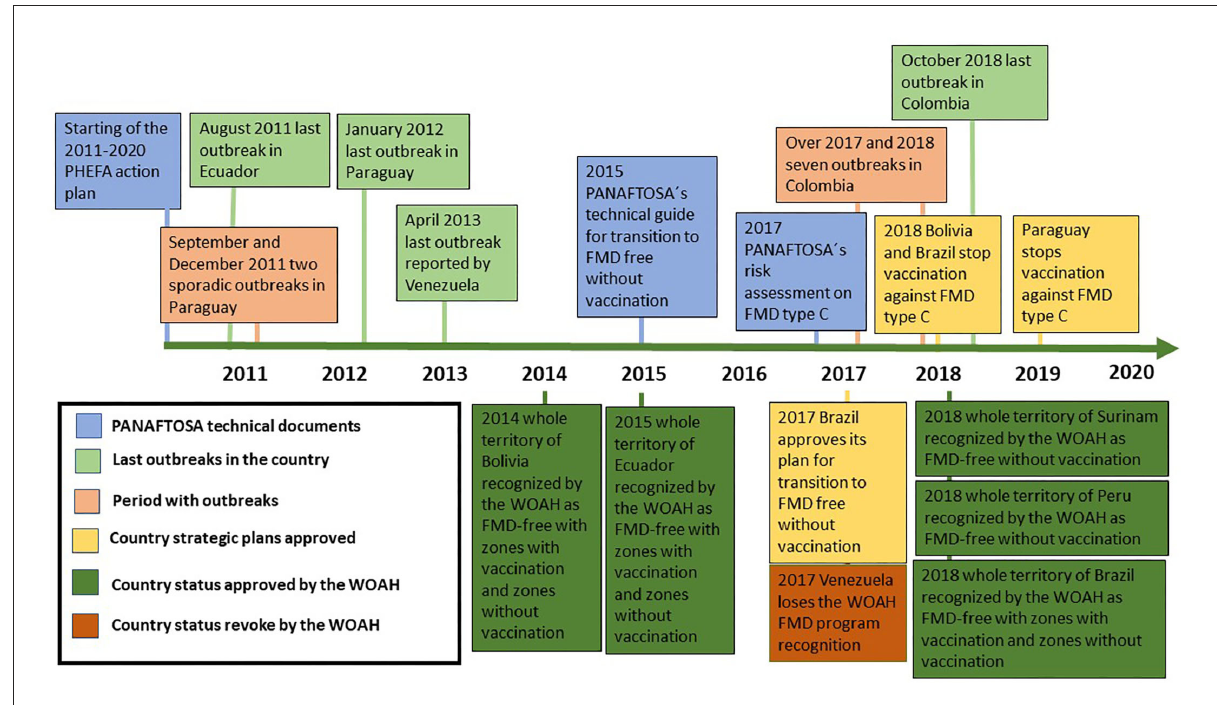
FIGURE2 Timeline of key events and milestones during the implementation of PHEFA